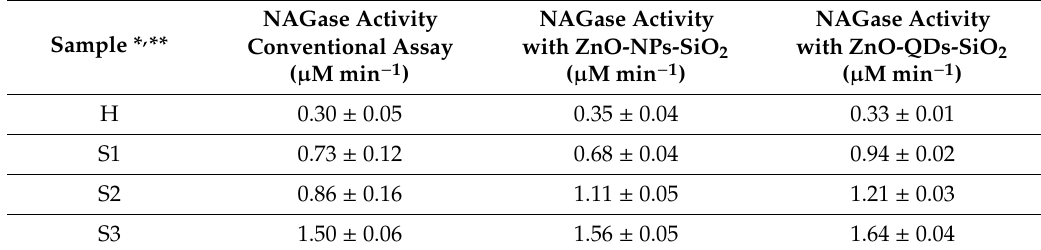
Table 2. NAGase activity in milk samples with and without the addition of ZnO-QDs-SiO 2 and ZnO-NPs-SiO 2 onto the reaction